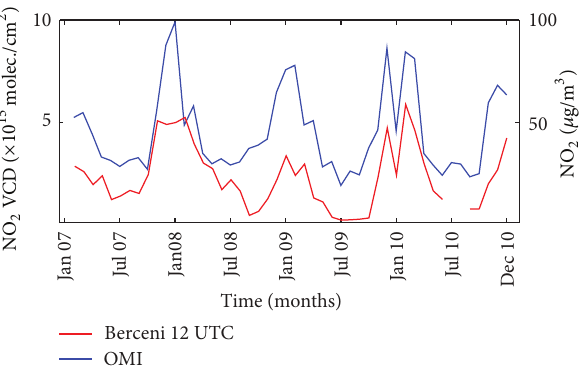
Figure 7: Comparison between OMI observations and in situ measurements for the Berceni (industrial) area in Bucharest at